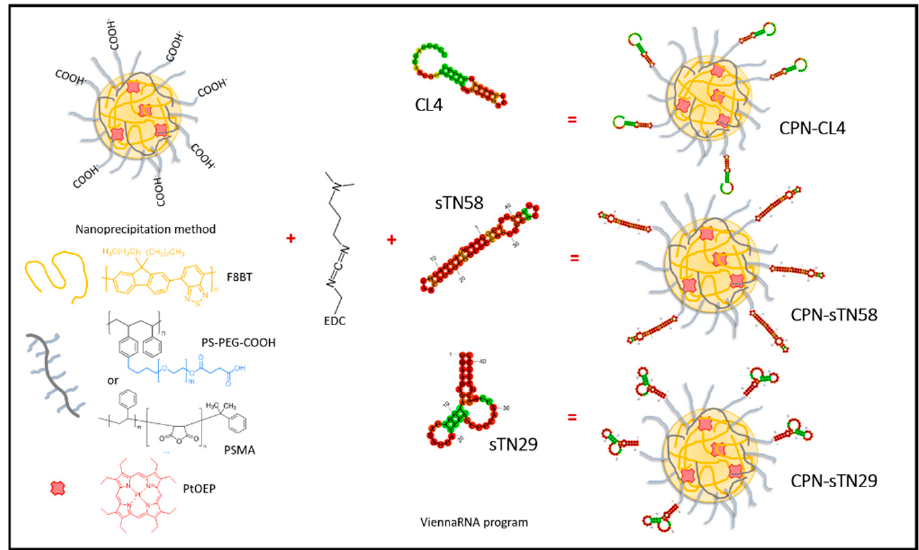
Figure 1. Aptamer decoration of metallated porphyrin-doped CPNs using EDC coupling reaction for photodynamic therapy of TNBC cells.